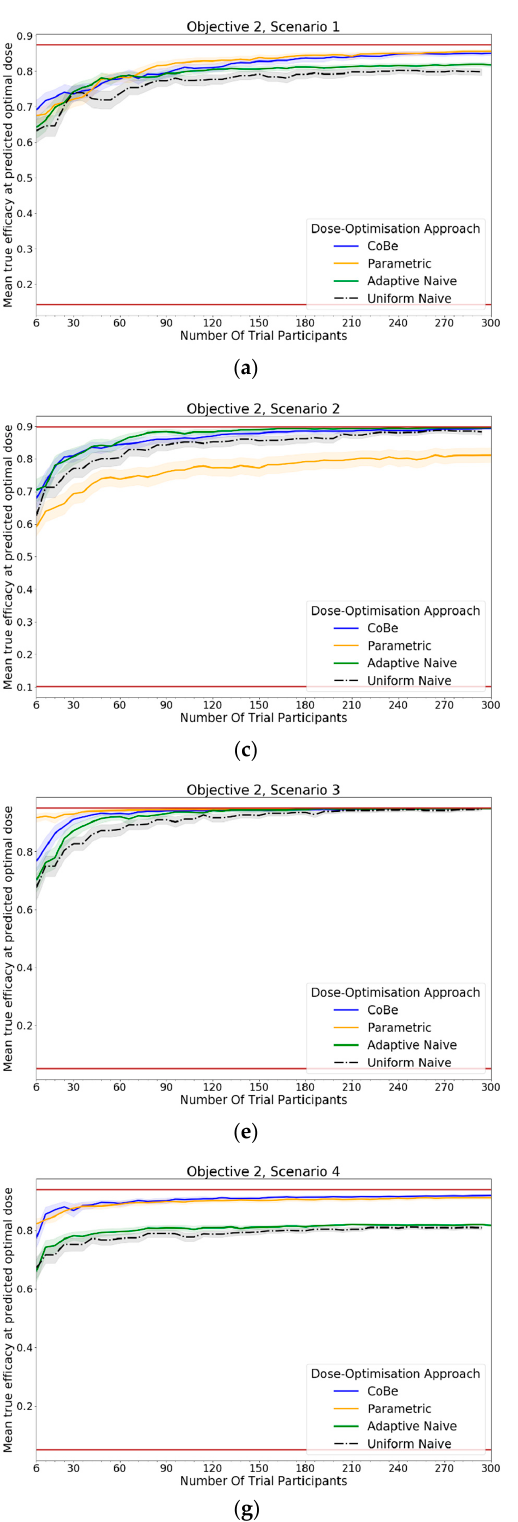
( n ) Figure 11. Mean true efficacy at the predicted optimal dose (left) and mean cumulative sum of effi- cacy (right) against trial size for all seven objective 2 scenarios (Scenario 1 ( a , b ), Scenario 2 ( c , d ), Scenario 3 ( e , f ), Scenario 4 ( g , h ), Scenario 5 ( i , j ), Scenario 6 ( k , l ), Scenario 7 ( m , n )). These are the mean values and 95%CI values across 100 simulations. For the true efficacy plots (left), the brown lines show the minimum and maximum possible efficacy that could be achieved in that scenario. For the cumulative efficacy plots (right) the brown lines represent the maximum and minimum cumulative efficacy sum that could be expected for that scenario.